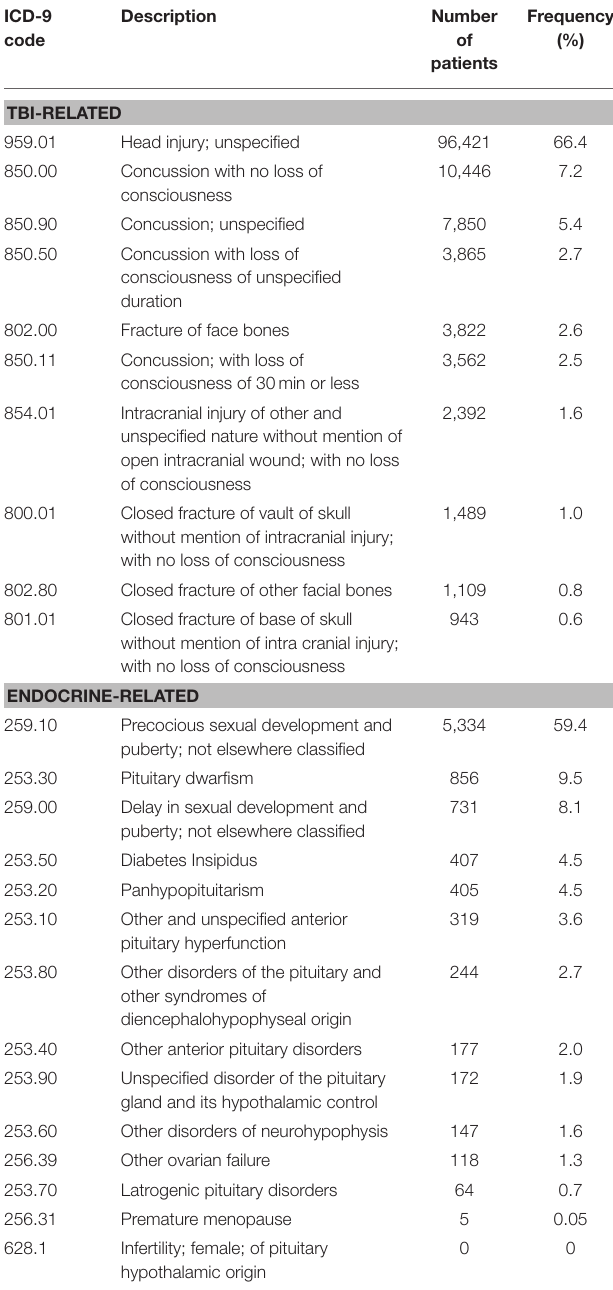
TABLE 4 | Top 10 reported ICD-9 codes for TBI-related diagnoses, and 14 ICD-9 codes for endocrine related diagnoses. ICD-9